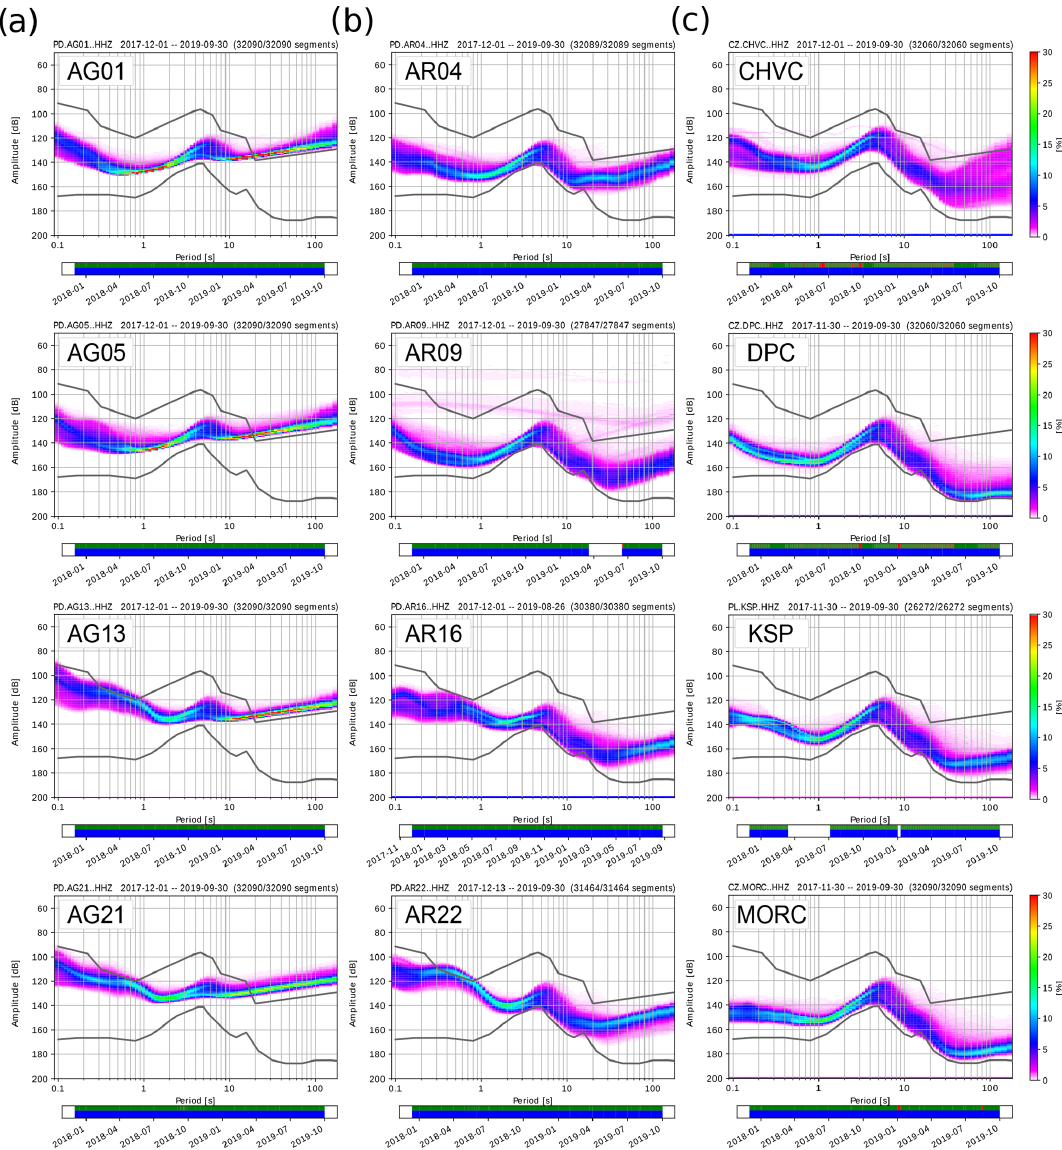
Figure 12. Probabilistic power spectral density (PPSD) on the Z component for 12 selected stations. (a) CMG-6T sensors, (b) RT 151–120 sensors, (c) permanent stations. Black lines mark new high and low noise models (NHNM, NLNM; Peterson, 1993).